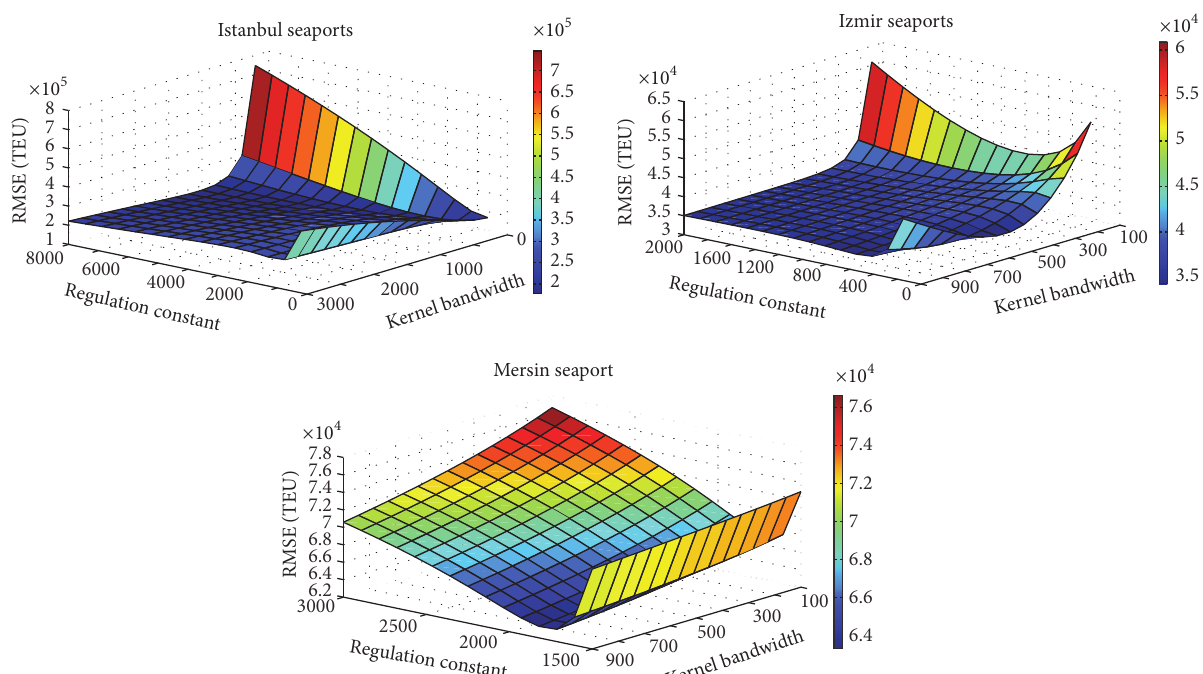
Figure 4: RMSE variation with respect to LSSVM model parameters for Istanbul, Izmir, and Mersin seaports for the testing period data.